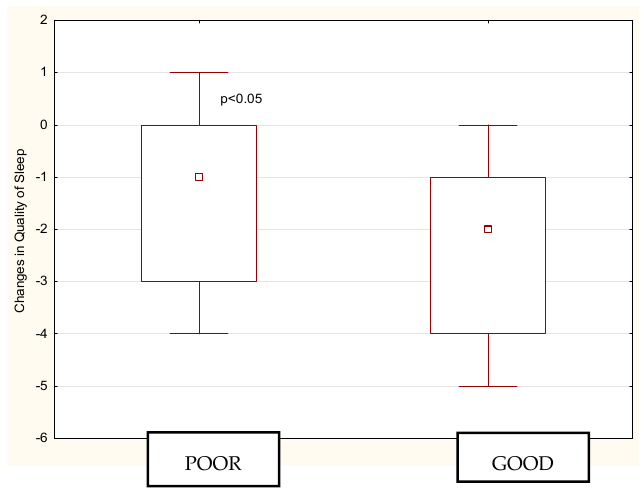
Figure 1. A subanalysis of sleep quality changes among poor sleepers vs. good sleepers (before Ramadan).